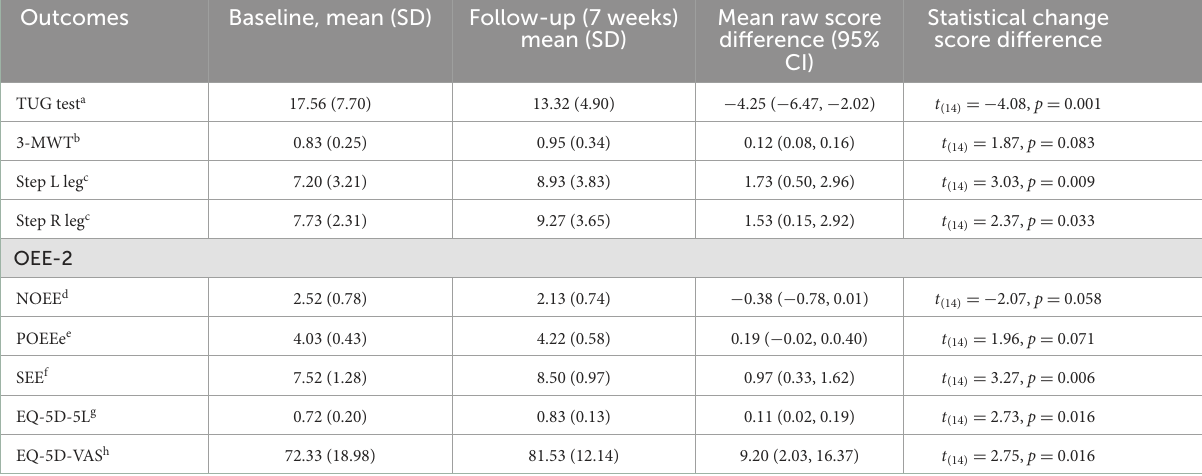
TABLE 2 Changes in participants’ functional outcome measures between baseline and follow-up.